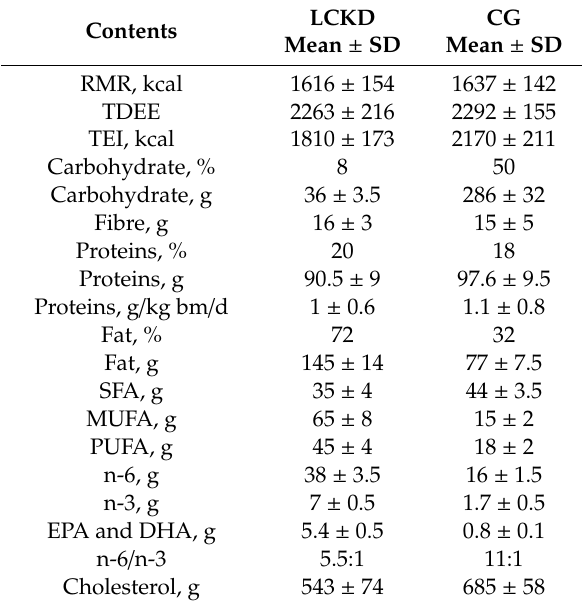
Table 1. Average macronutrients and total energy content of the low-calorie ketogenic diet (LCKD) group and the control group (CG) reported during the